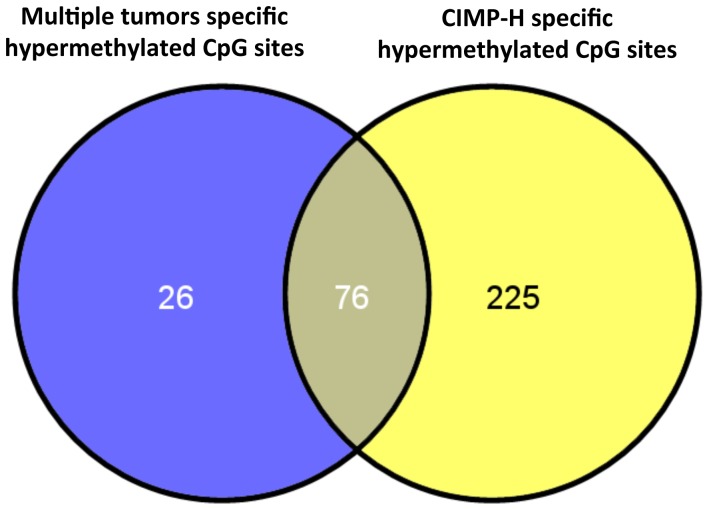
Overlap between significantly hypermethylated CpG sites in multiple and CIMP-H tumors.Blue circle shows 102 hypermethylated CpG sites found in multiple versus solitary tumors and yellow circle shows the 301 hypermethylated CpG sites in CIMP-H versus CIMP-L/0 tumors. Remarkably, 76 out of the 102 hypermethylated genes in multiple tumors were also seen to be hypermethylated in CIMP-H tumors, and are represented as an intersection.